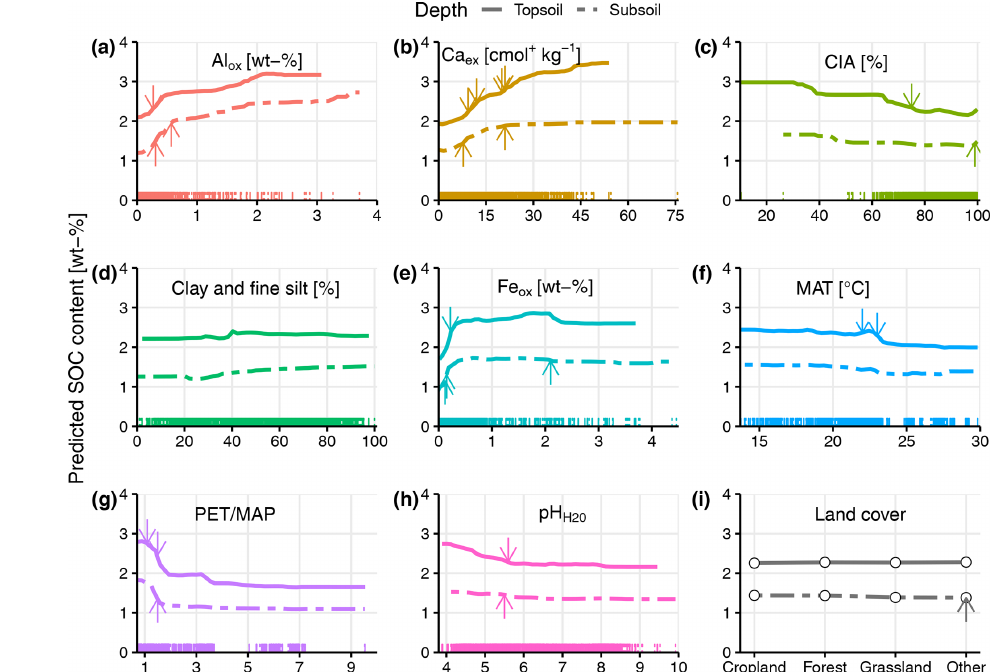
Figure 6. Partial dependence plot for each explanatory variable of the random forest models (topsoil and subsoil). The x axes always correspond to the range of the explanatory variable. Arrows indicate splitting points in the regression tree (Fig. A6). Each colored tick mark along the x axes represents one